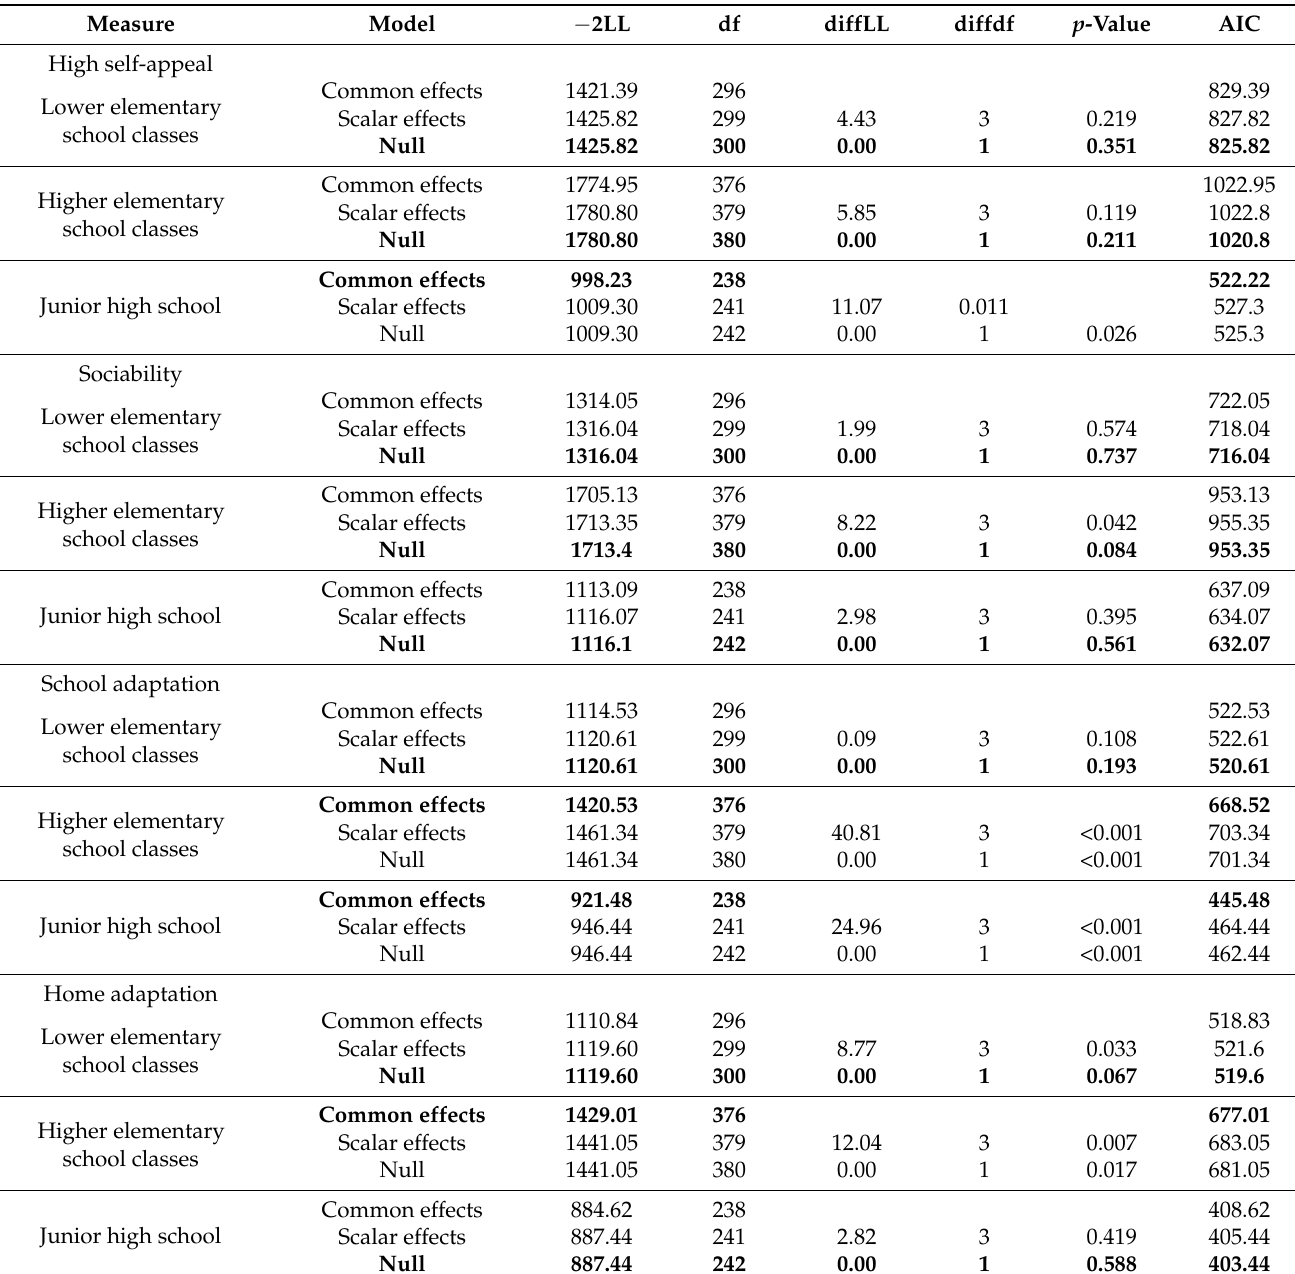
Table 5. Comparison of common effects, scalar effects models and null models to consider quantitative sex